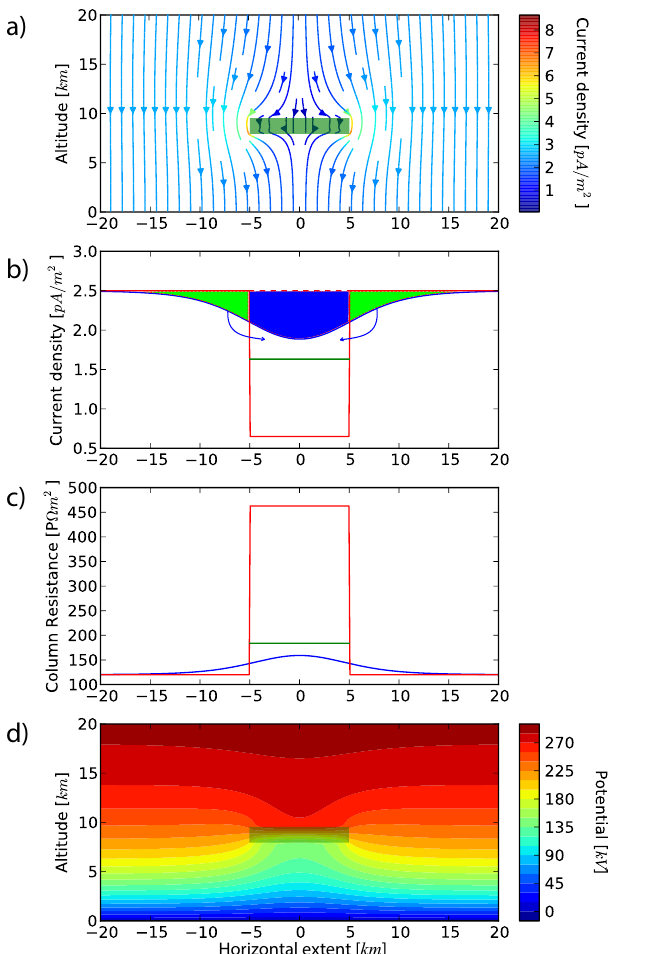
Figure 3. As Fig. 2 but for a stratus cloud between 0.5 and 2.5km